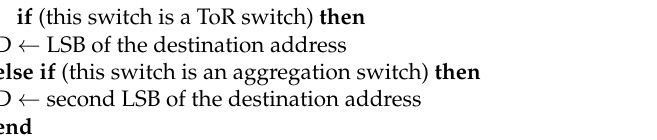
Figure 8. A switch is in one of the three states. qlen(i) indicates the queue length of an output port in link group i. Table 3. Determining a link group for a packet in each state.